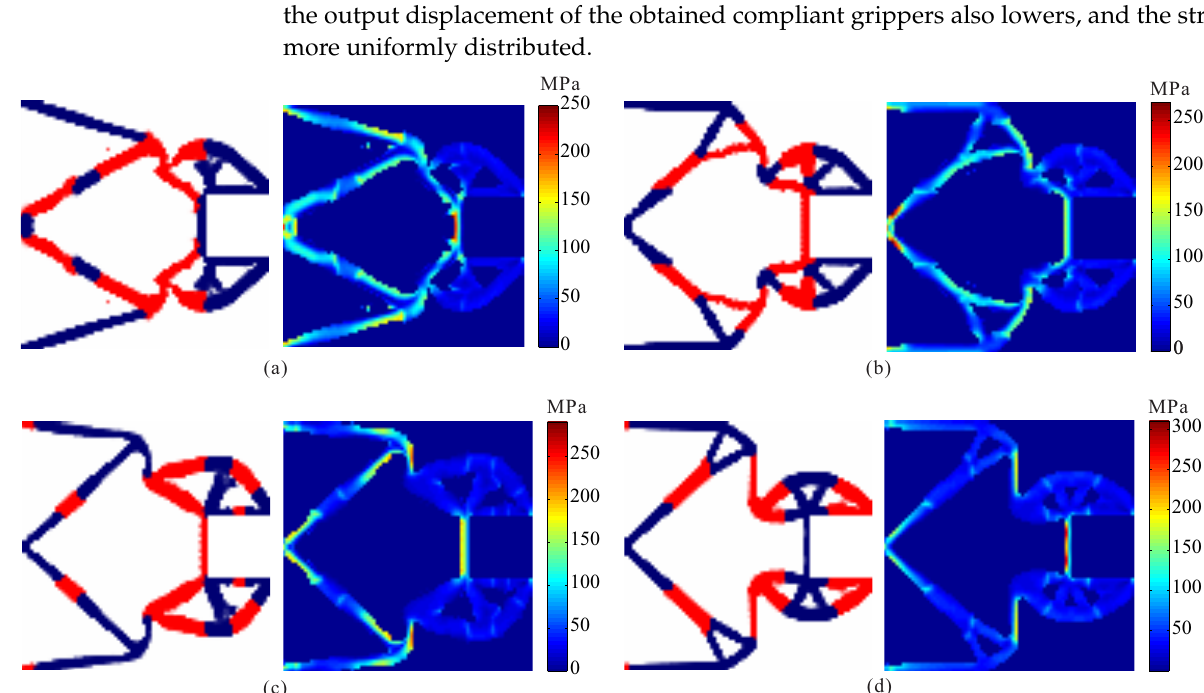
Figure 9. The convergence history for topological design of multi-material compliant gripper with global stress